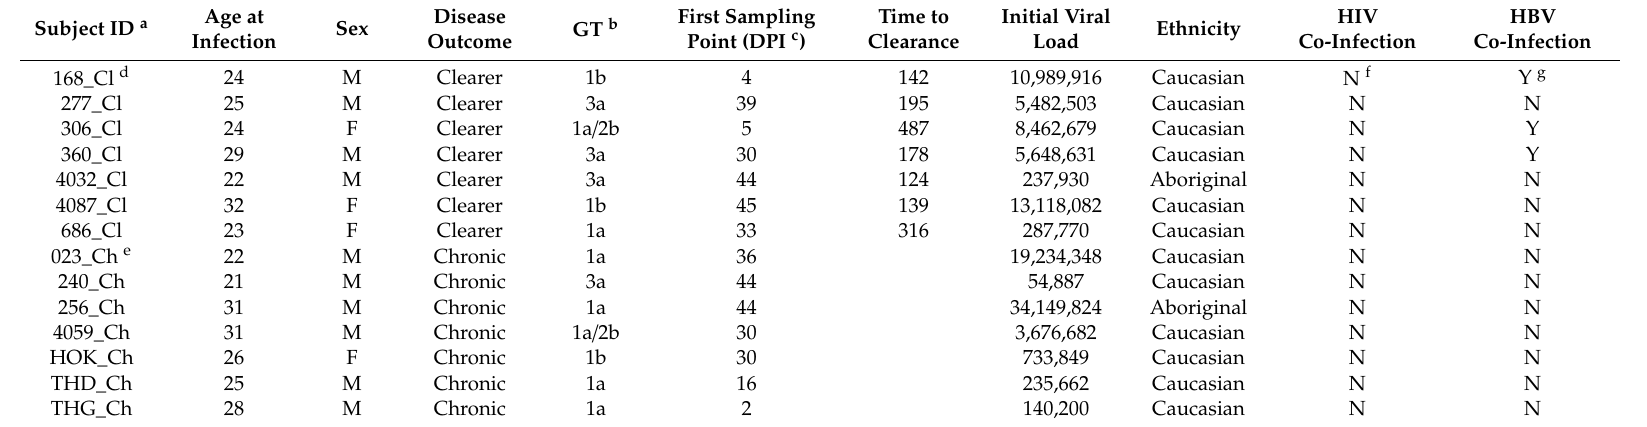
Table 1. Subject characteristics and time point